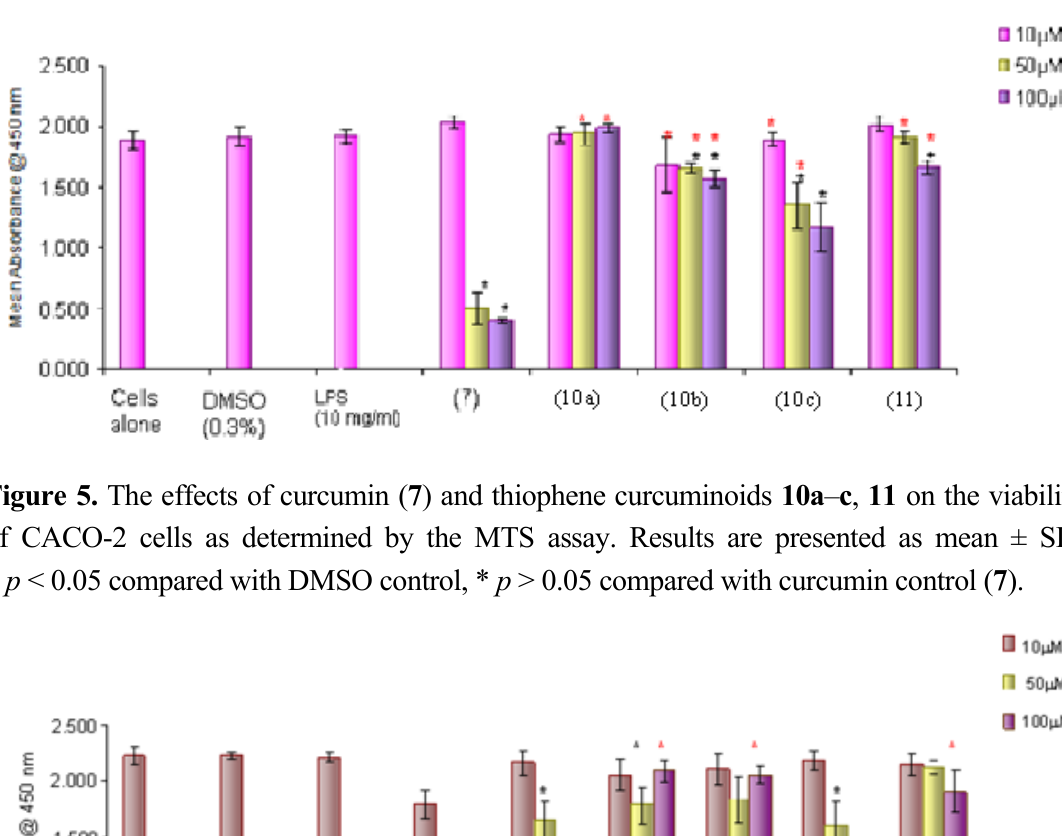
Figure 4. The effects of curcumin ( 7 ) and thiophene curcuminoids 10a – c , 11 on the viability of THP-1 cells as determined by the MTS assay. Results are presented as mean ± SD. * p < 0.05 compared with DMSO control, * p > 0.05 compared with curcumin control ( 7 ).